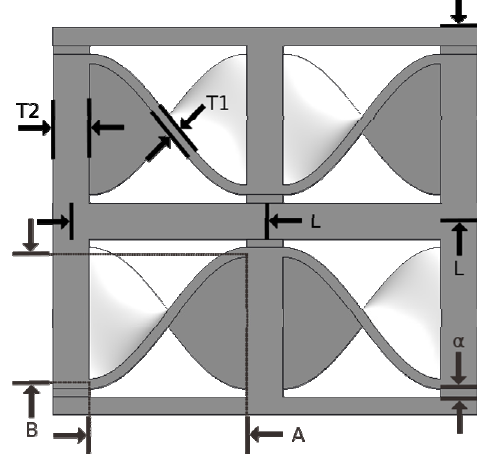
Figure 3. Geometrical parameters (front